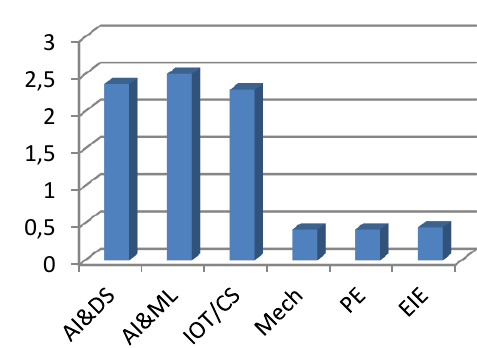
Figure 5: Weights of alternatives with respect to C 5